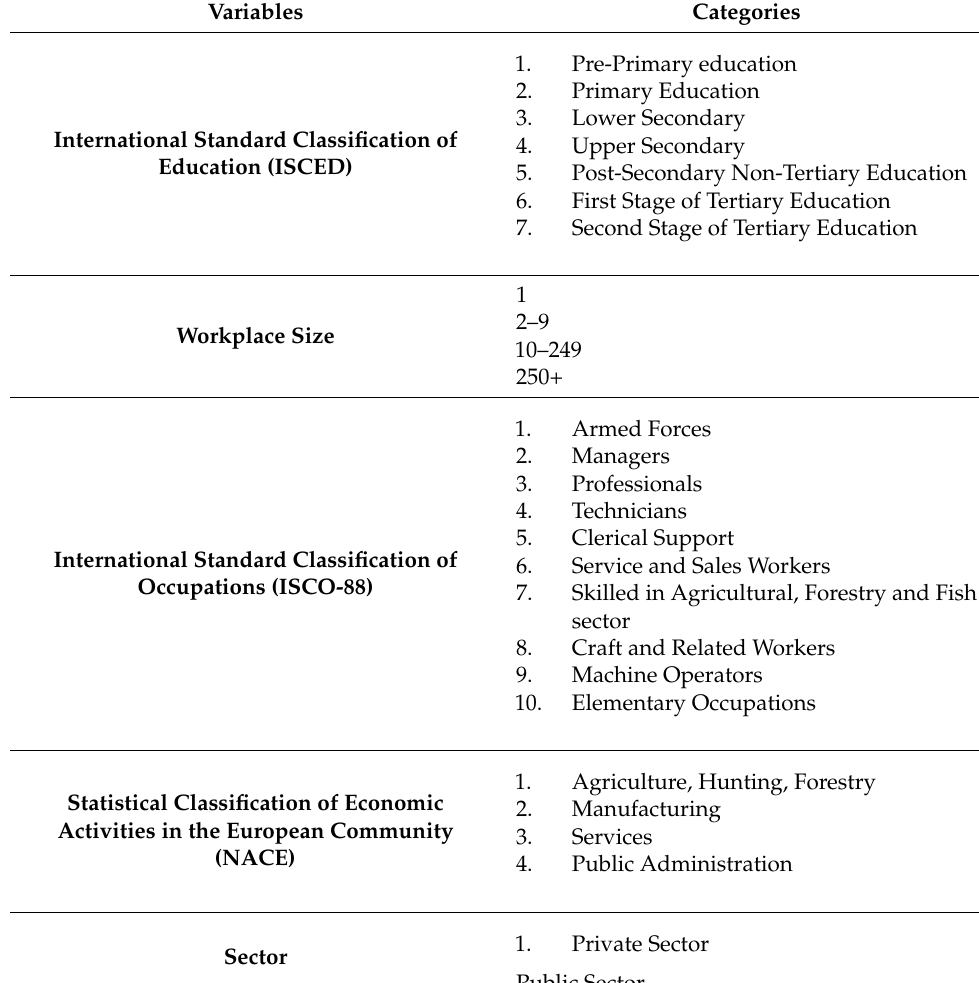
Table 1. Control Variables Employed in the Empirical